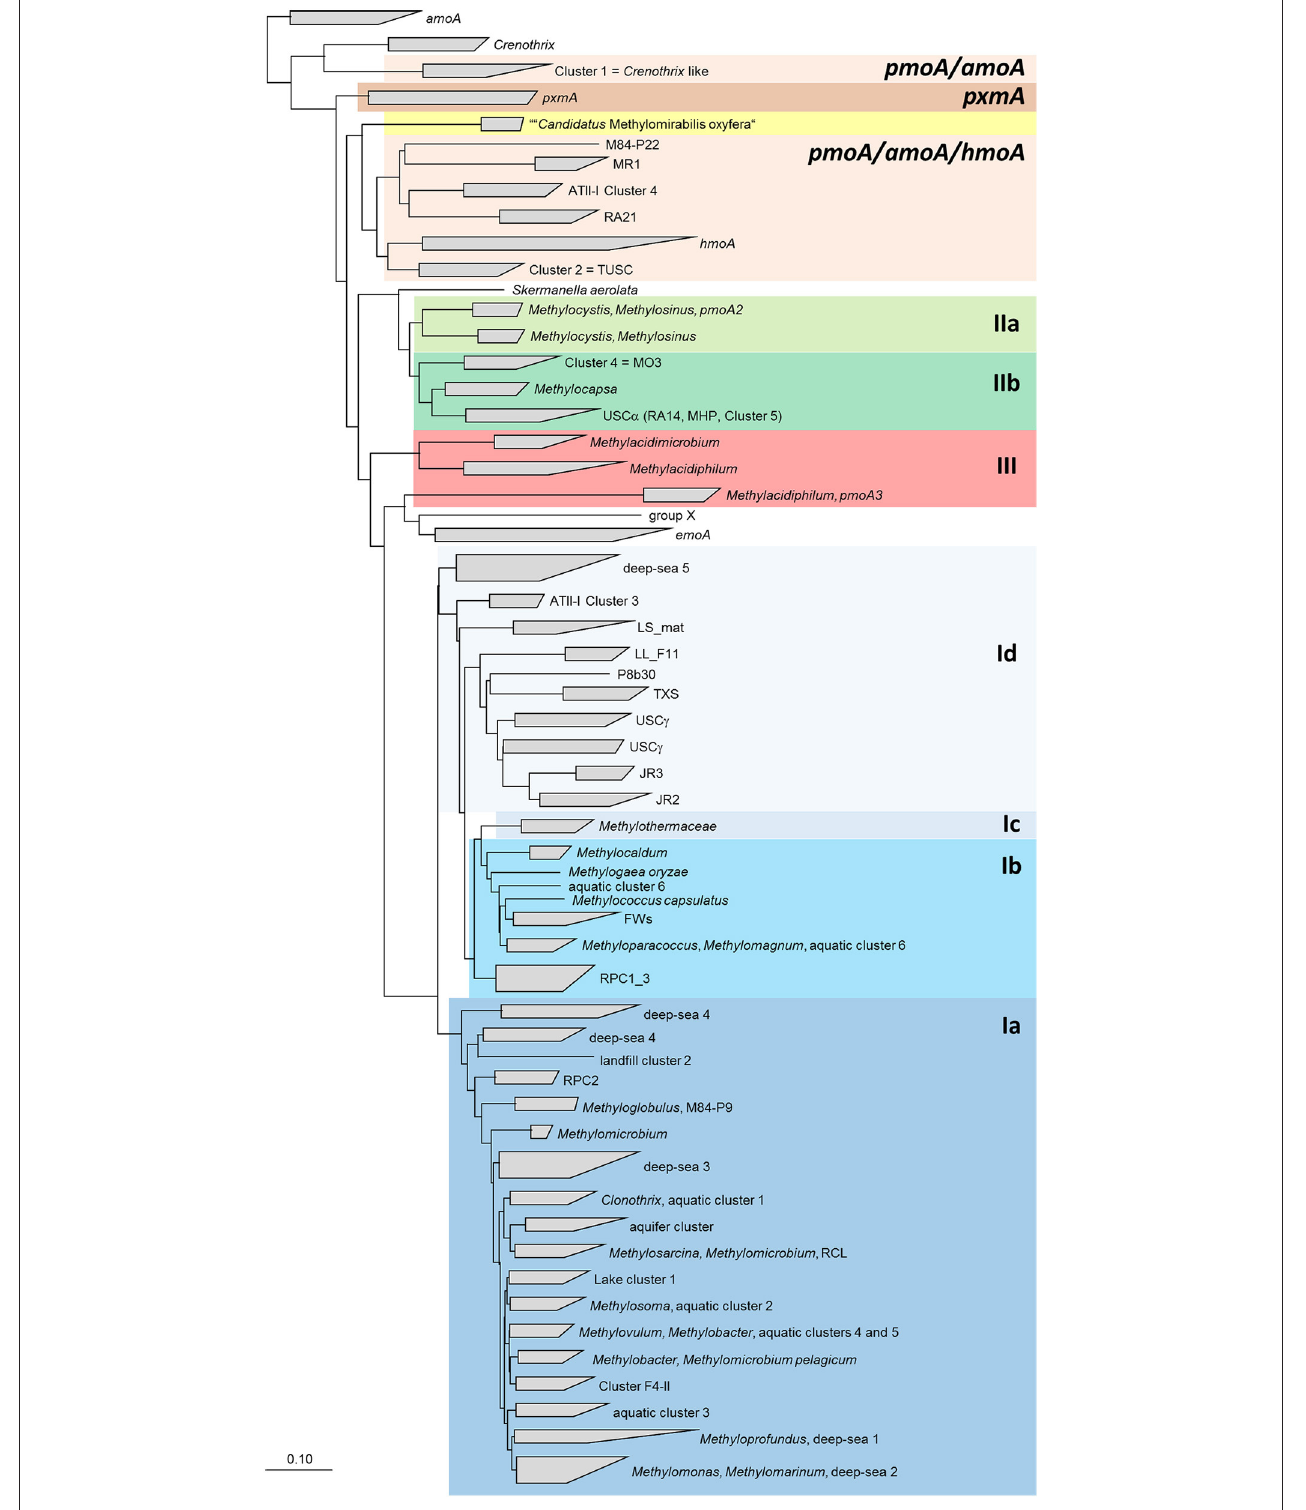
FIGURE 6 | Neighbor joining tree showing the phylogeny of uncultivated clusters in relation to methanotrophic type strains. The tree includes pmoA sequences from all OTUs that were assigned to uncultivated clusters. It was calculated based on 480 nucleotide positions with Jukes Cantor correction. The scale bars display 0.10 changes per nucleotide or amino acid